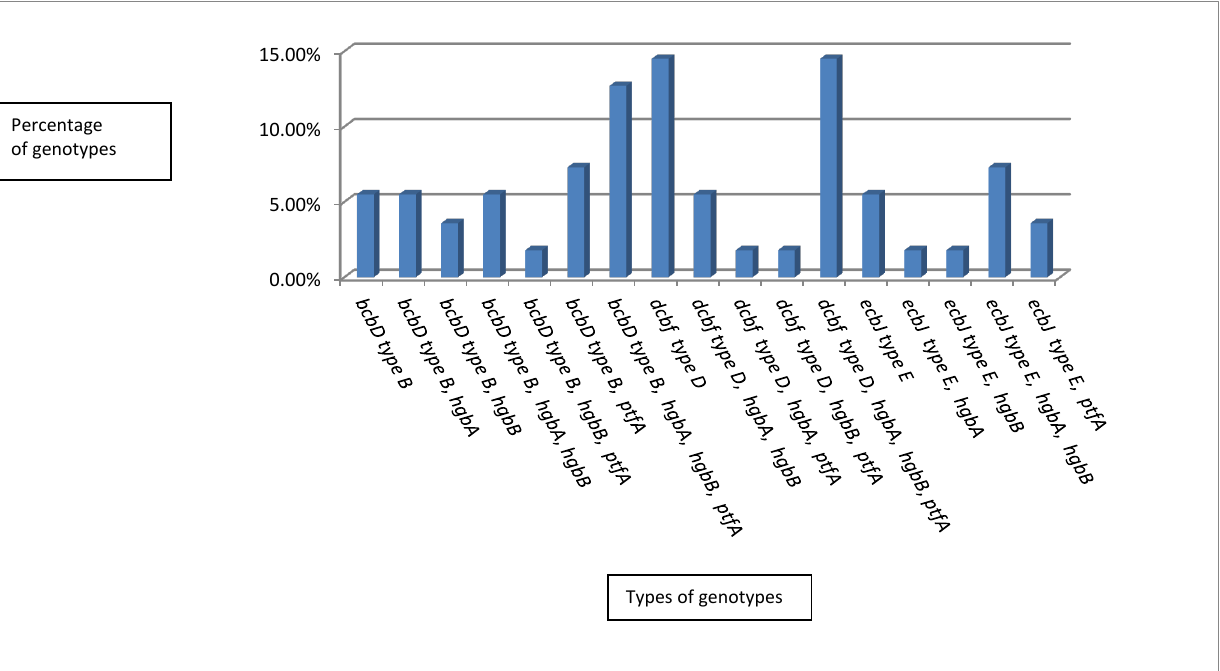
Figure 2. The percentages of the obtained genotypes.